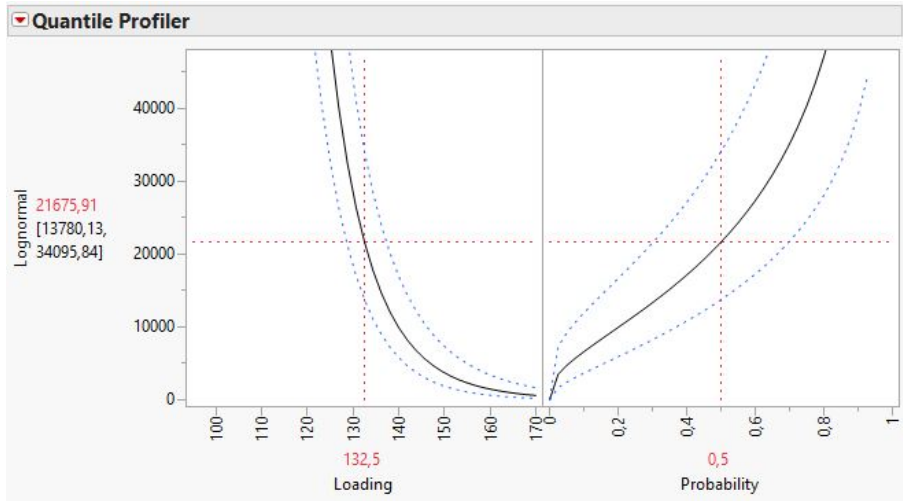
Figure 7. Quantile analysis for Material#1.